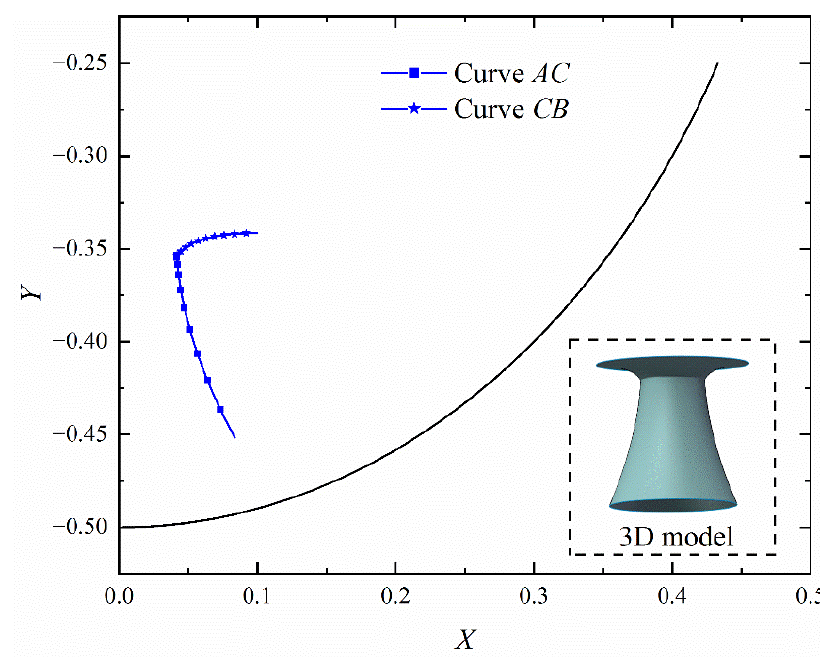
Figure 8. The optimal generatrix of the photoelectric conversion system.